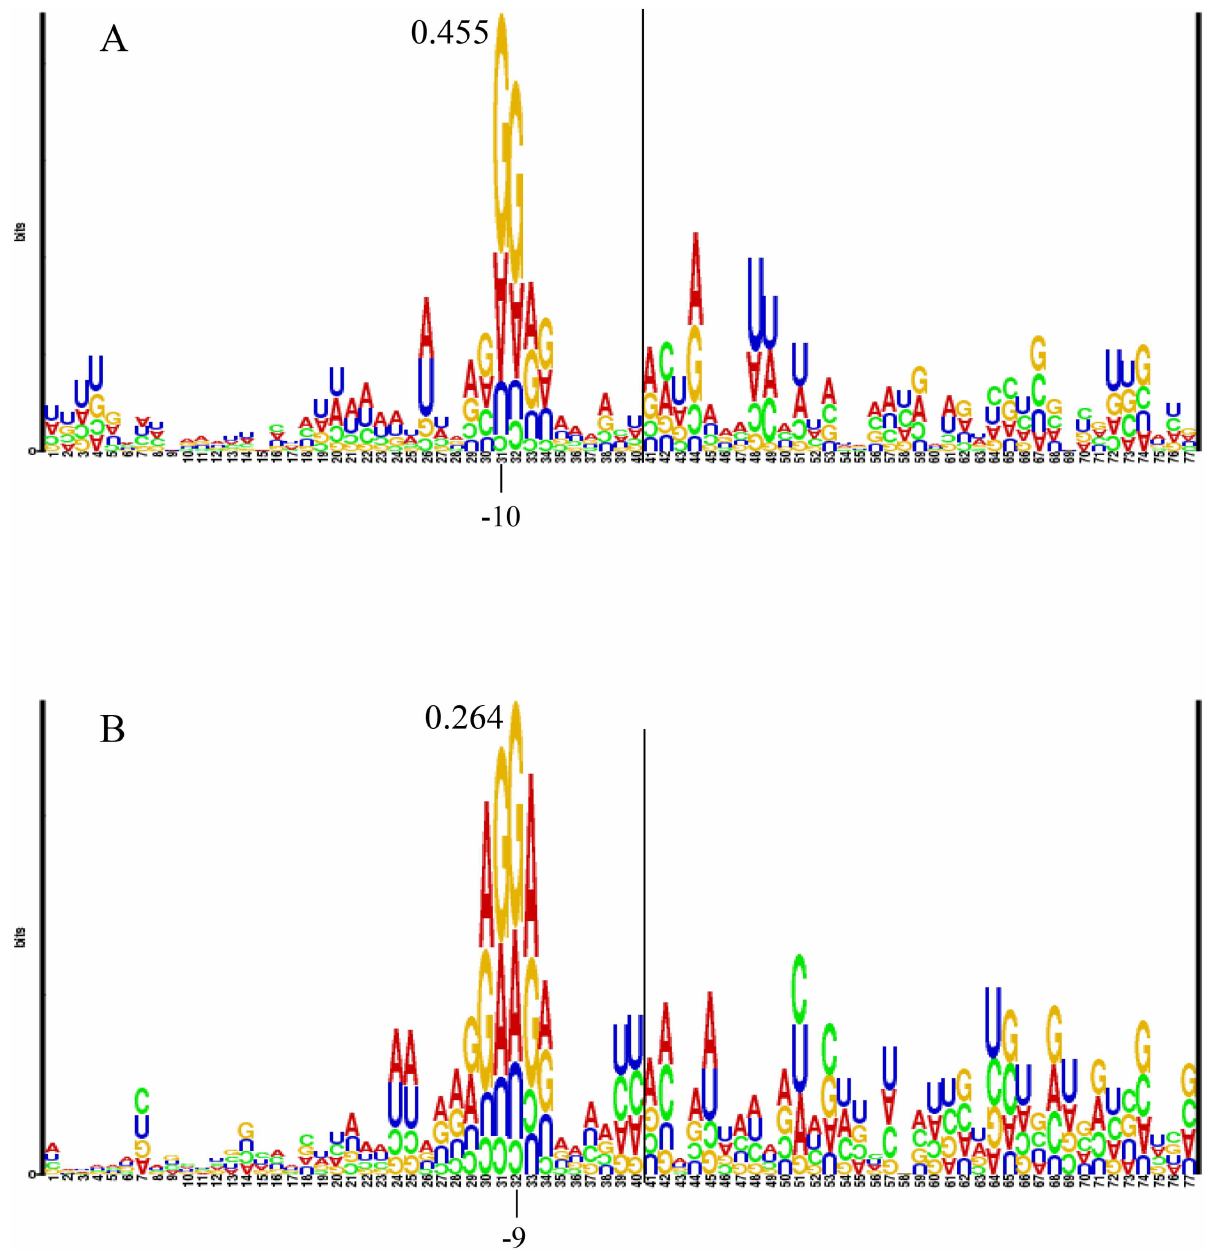
Fig 4. RNA Structure Logos of the groups of Kasugamycin sensitive and Kasugamycin-resistant genes. For the respective genes 40 nt upstream of the start codon and the first 40 nt of the open readingframes were retrieved from the databaseEcoGene3. The start codons were removedand the sequenceswere used to generateRNA Structure Logosat http://www.cbs.dtu.dk/~gorodkin/appl/slogo.html. RNA Structure LOGOS show the deviationof the occurrences of the four nucleotides at any position of a multiplesequencealignment from the statistical expectations based on the respectivefractions of the four nucleotieds of the input sequences. The height of the nucleotides correspondsto the degreeof deviation. Upright nucleotides have a higheroccurrence as expected, invertednucleotidesa lower occurrence. A line indicates the border betweenthe 40 nt upstream and the 37 nt downstreamof the start codon. The informationcontent (in bits) of the highestposition is indicated A. LOGO of 102 Kasugamycin-sensitive genes(KEVs of < 0.5 in S1 Table). B. LOGO of 137 Kasugamycin-resistant genes(KEVs > 2.0 in S1